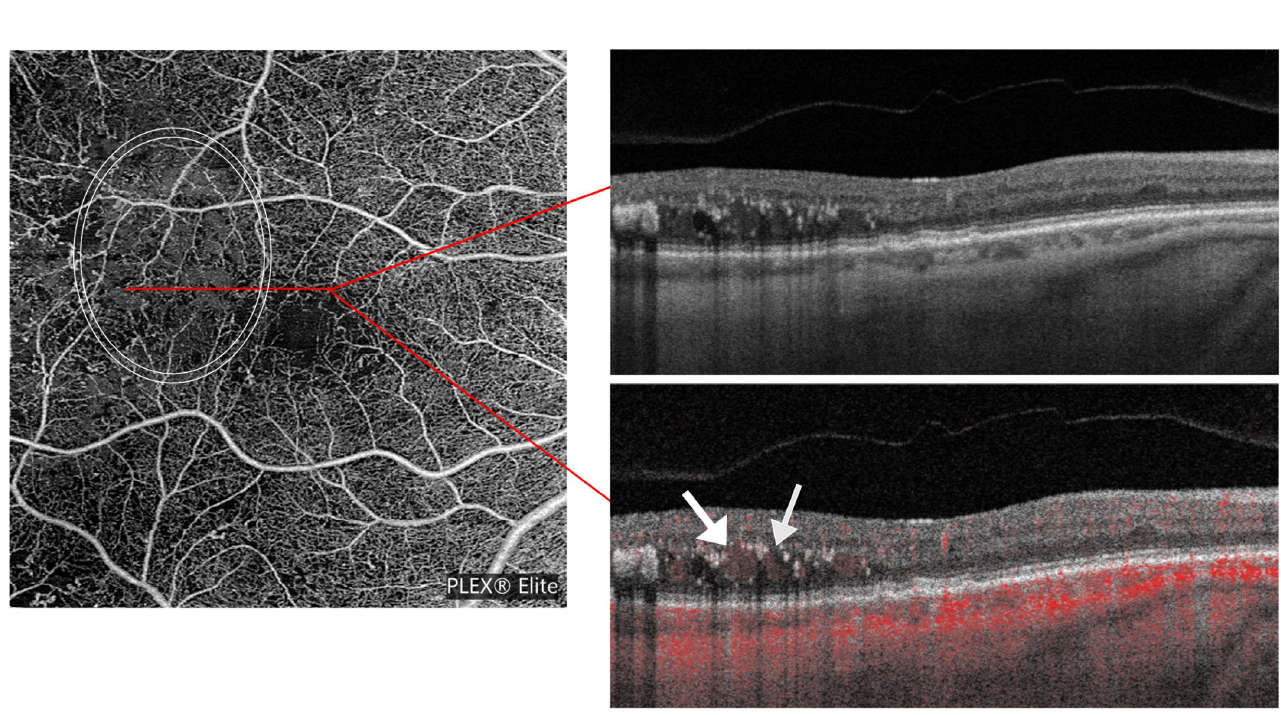
Fig 3. Example of annotated artifacts with flow around the cysts on OCTA images. On the left is an OCTA image of the retina slab. On the upper and lower right a B-scan of the location marked by the red line. On the upper right the B-scan is shown without perfusion representation, on the lower right with perfusion in red. The white arrows mark the perfusion around the cysts. Hyperreflective material is visible surrounding the cysts.